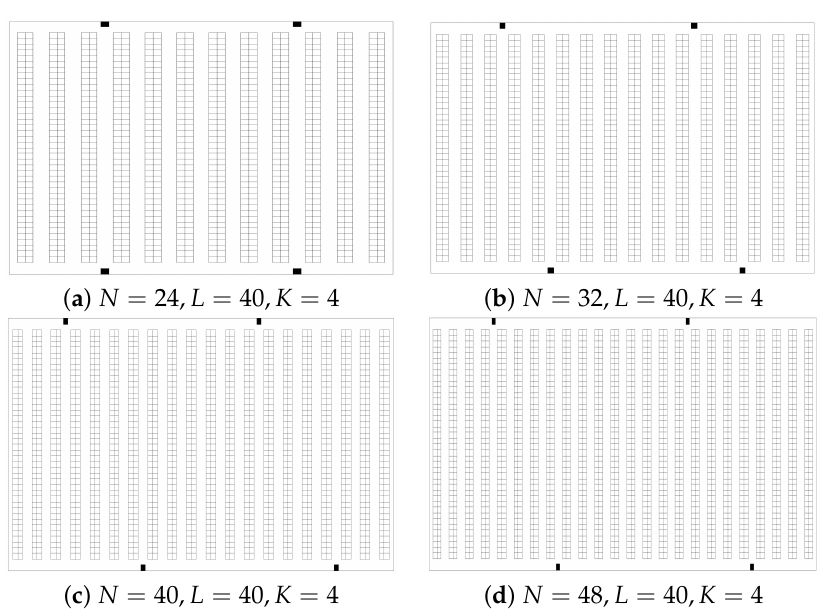
Figure 8. Optimal workstation layout under different N (i.e., number of